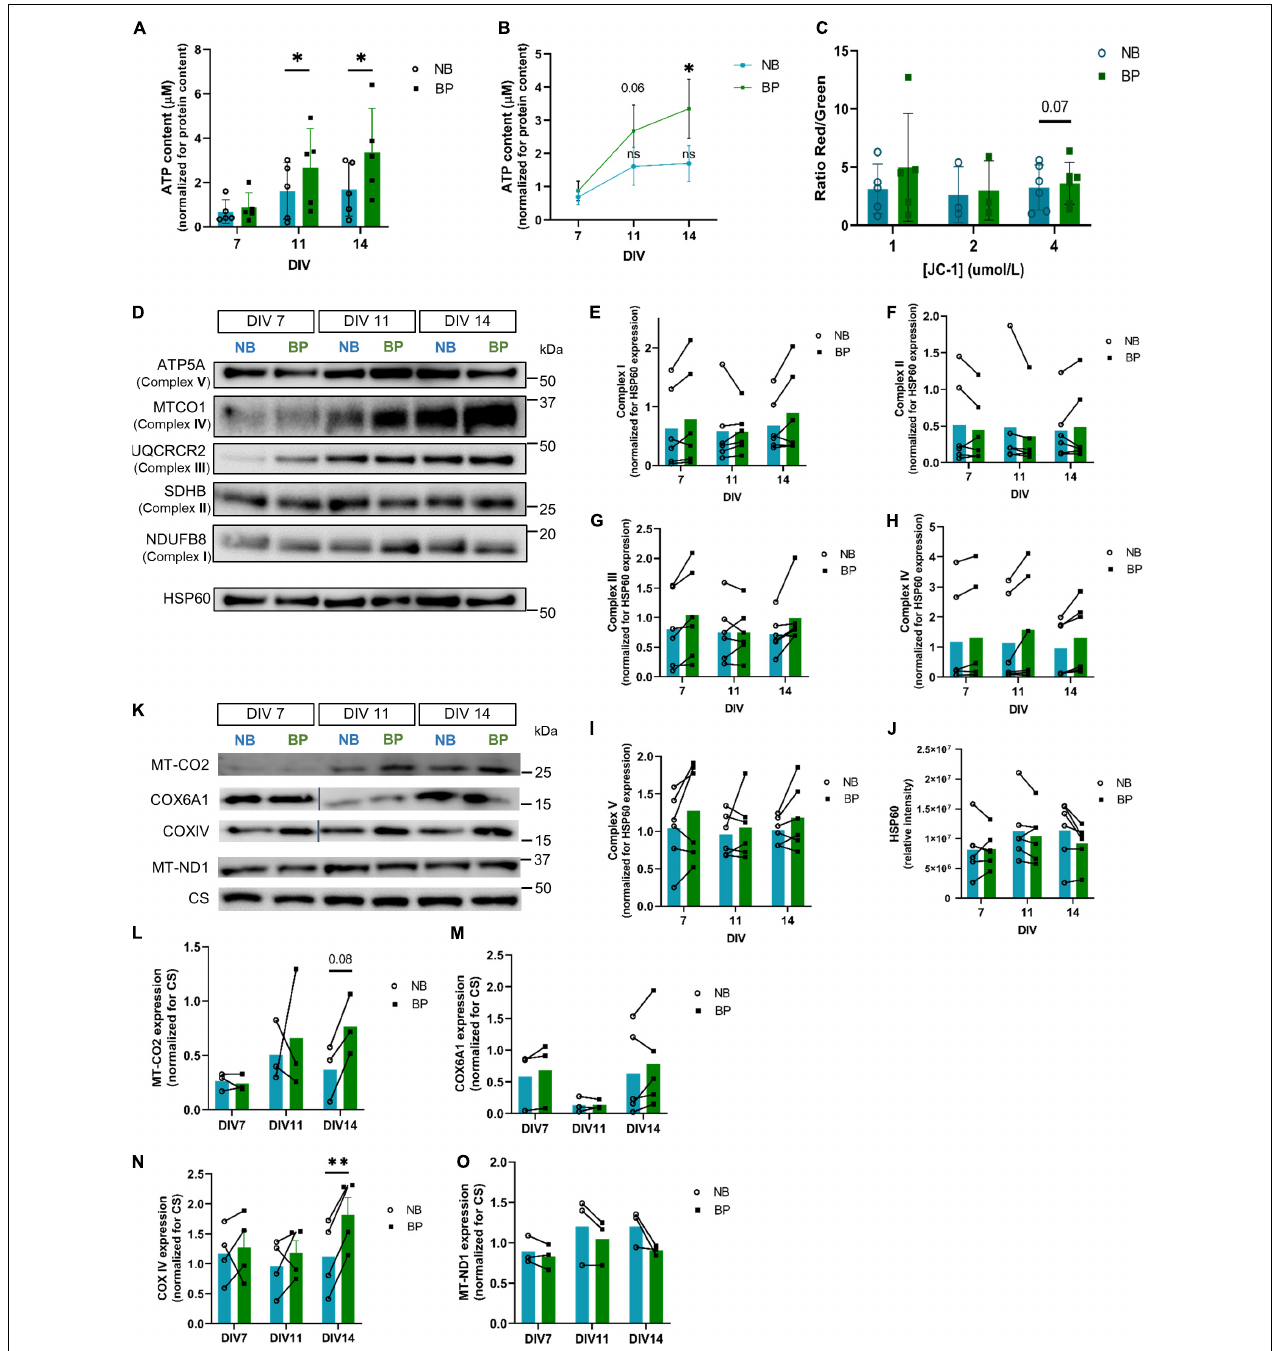
FIGURE 2 | Mouse neurons maintained in BP medium present increased ATP content and increased expression of OxPhos proteins. (A) Comparison of ATP content between NB and BP neurons at DIV 7, 11, and 14 ( n = 5–8 biological replicates) and (B) in NB and BP neurons throughout neuronal maturation ( n = 5 biological replicates); (C) mitochondrial membrane potential measured by the quantification of red to green fluorescence ratio of DIV9 neurons maintained in NB or BP medium using different concentrations of JC-1 ( n = 3–6 biological replicates); protein expression (D) and quantification of a subunit of each oxidative phosphorylation complex: NDUFB8 (Complex I) (E) , SDHB (Complex II) (F) , UQCRCR2 (Complex III) (G) , MT-CO1 (Complex IV) (H) , and ATP5A (Complex V) (I) in NB and BP neurons at DIV7, DIV11, and DIV14. Band intensities were normalized for mitochondrial matrix protein HSP60 expression ( n = 6 biological replicates) (J) ; protein expression (K) , and quantification (L–O) of Complex IV and I mitochondria I-encoded subunits—MT-CO2 and MT-ND1, respectively, and Complex IV nuclear-encoded subunits—COX6A1 and COXIV in NB and BP neurons at DIV 7, 11, and 14. Band intensities were normalized for Citrate Synthase (CS) expression ( n = 3–4 biological replicates). All bar graphs show means ± SEM, determined by unpaired student’s t -test with Welch’s correction (A,C) , a two-way ANOVA followed by Bonferroni’s multiple comparisons post hoc test (E–J,L–O) , and a one-way ANOVA with Tukey’s correction (B) , ∗ p < 0.05, ∗∗ p < 0.01.